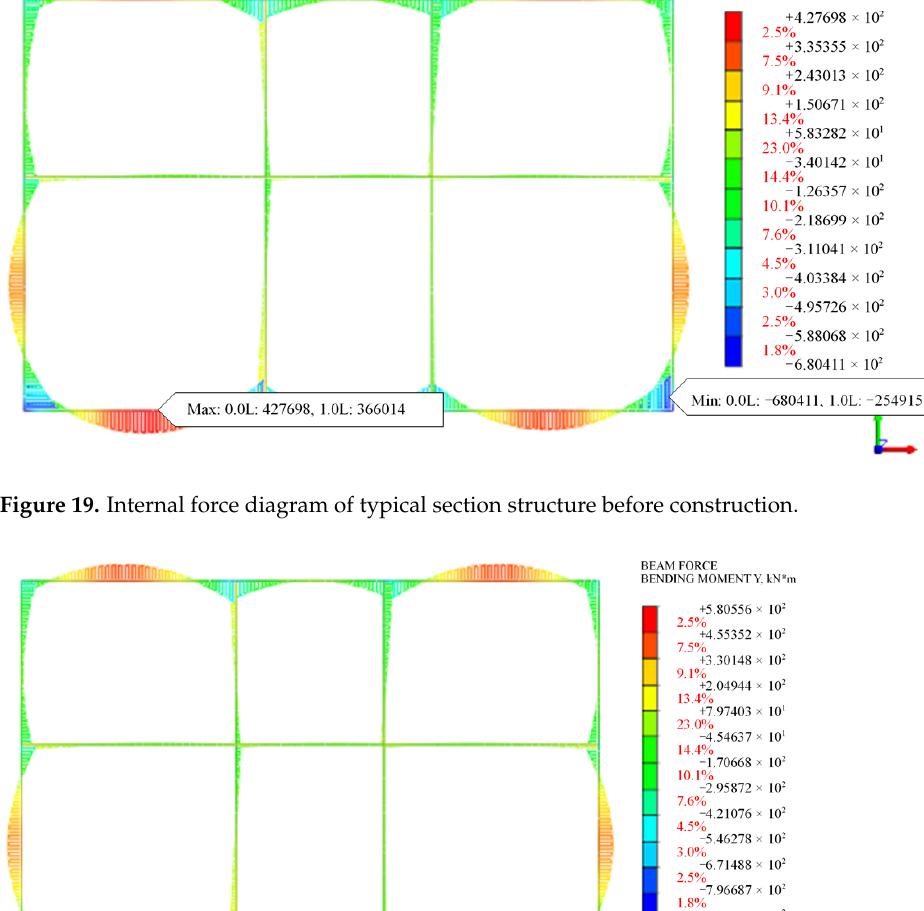
Figure 20. Internal force diagram of typical section structure after construction.